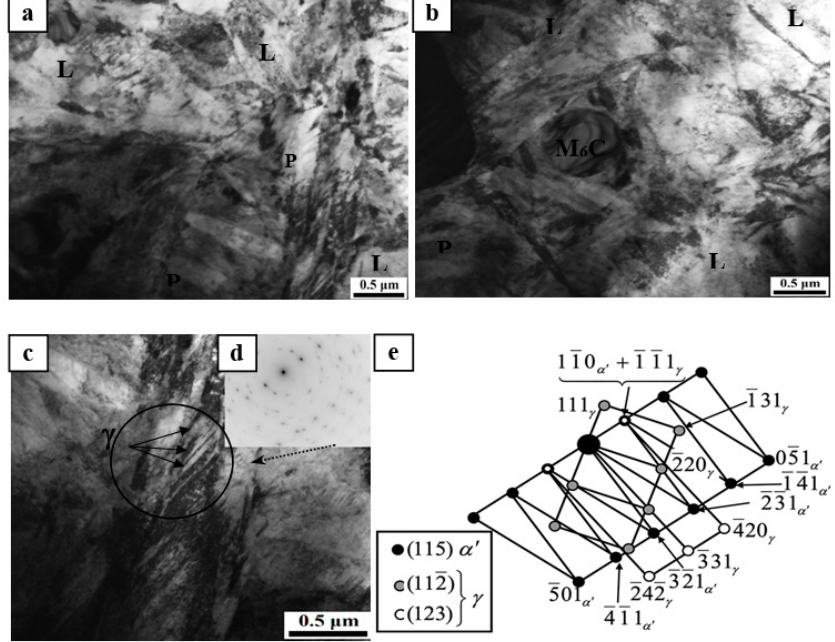
Figure 5. TEM images of the fine structure of R6M5 steel after impacts by an electron beam ( a – c )— bright-field images; ( d )—microdiffraction pattern and ( e )—indicated scheme.